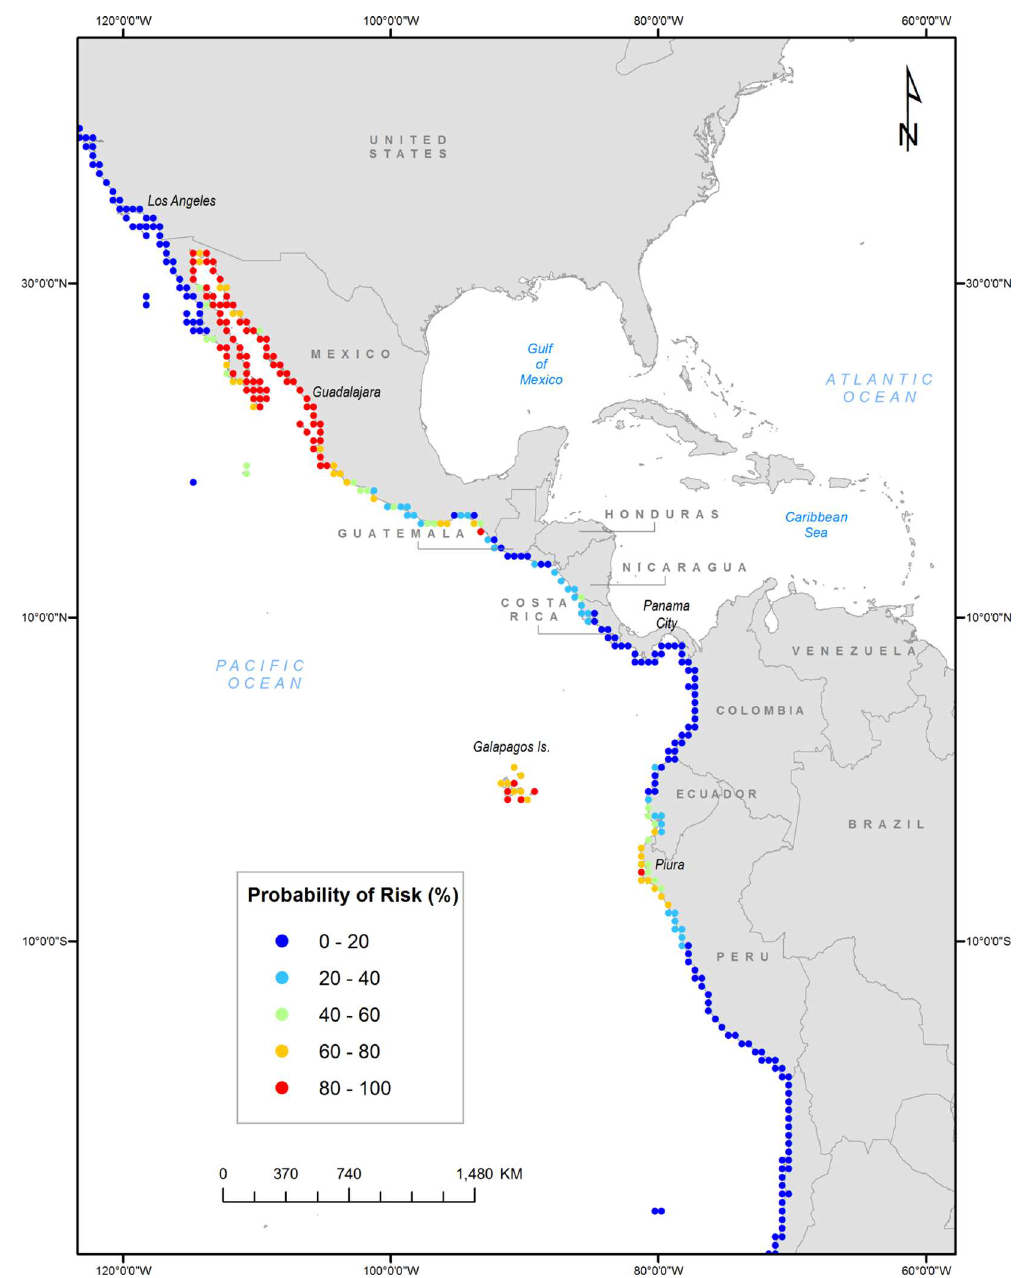
Fig 1. Predicted suitability for lionfish on the west coast of North, Central and South America. Made with Natural Earth.